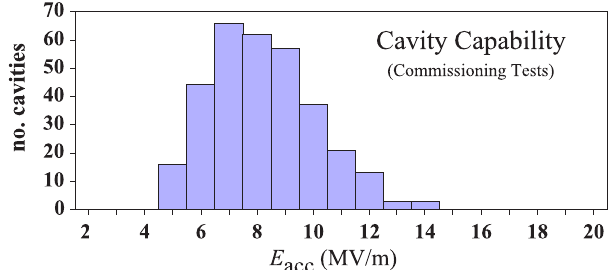
FIG. 7. CEBAF cavity usable performance per tunnel com- missioning tests (from